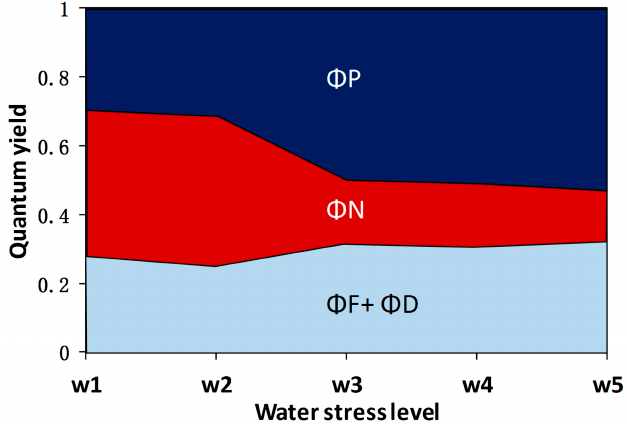
Figure 1. Typical fluctuations in the quantum yield of photochemistry in PSII ( Φ P ), the quantum yield of non-photochemical quenching ( Φ N ), the quantum yield of fluorescence ( Φ F ) and constitutive heat dissipation ( Φ D ), at different water stress levels. (1) W1: 20% FC < SWC < 35% FC;